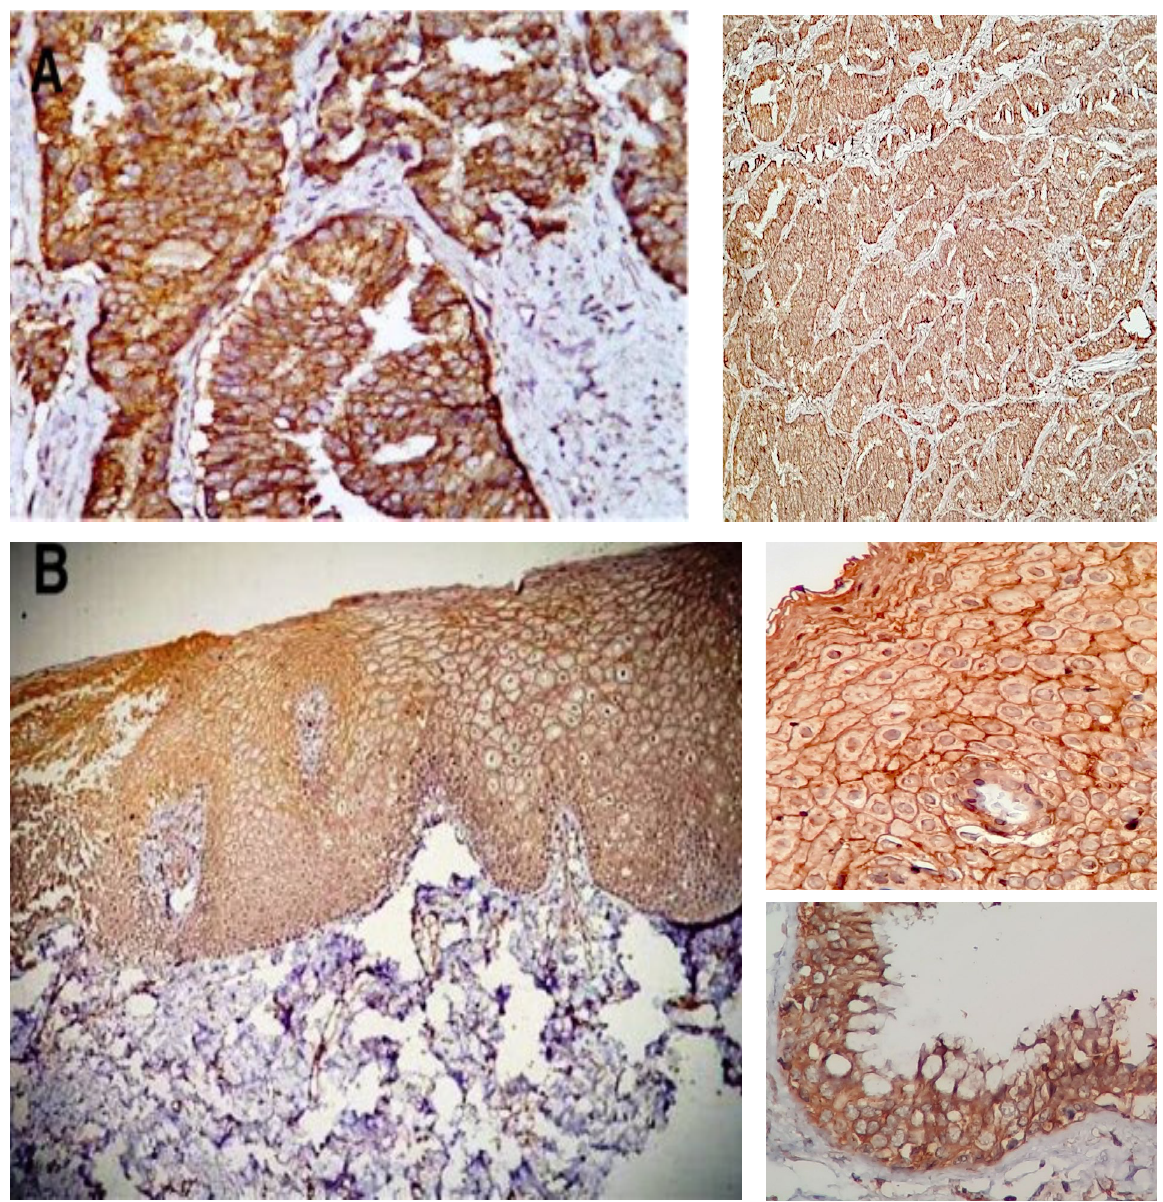
Fig 1. Illustrated IHC stained slides with Anti galectin-8 antibody, under light microscope, revealed: A- Positive prostatic adenocarcinoma as control sample, that neoplastic glands colored brown and the stroma-colored violet, by 400× magnification. B- Normal squamous epithelium and its strong positive cytoplasmic staining that merging to cell membrane. also, good staining of the cell nuclei is in evident, by 200×magnification.text box shows high power view of squamous epithelium and respiratory